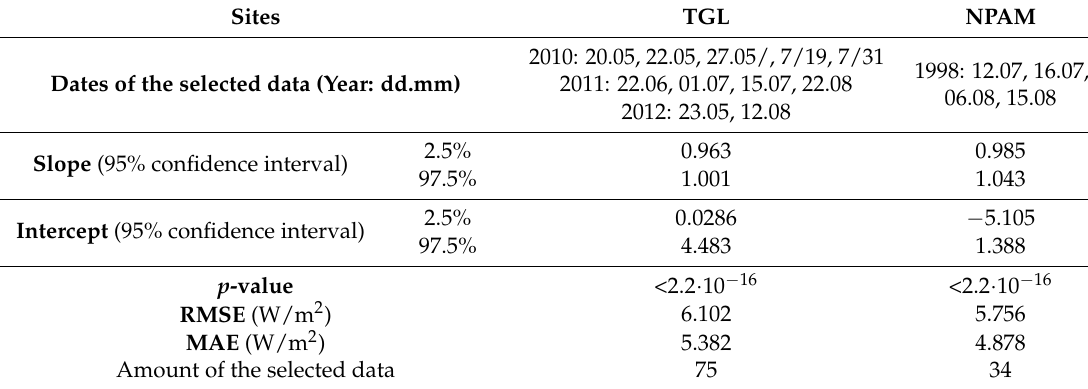
Table 7. The uncertainties in the simulated G 0 by the Ma impr scheme using in situ data from TGL and NPAM stations. Sites TGL NPAM Dates of the selected data (Year: